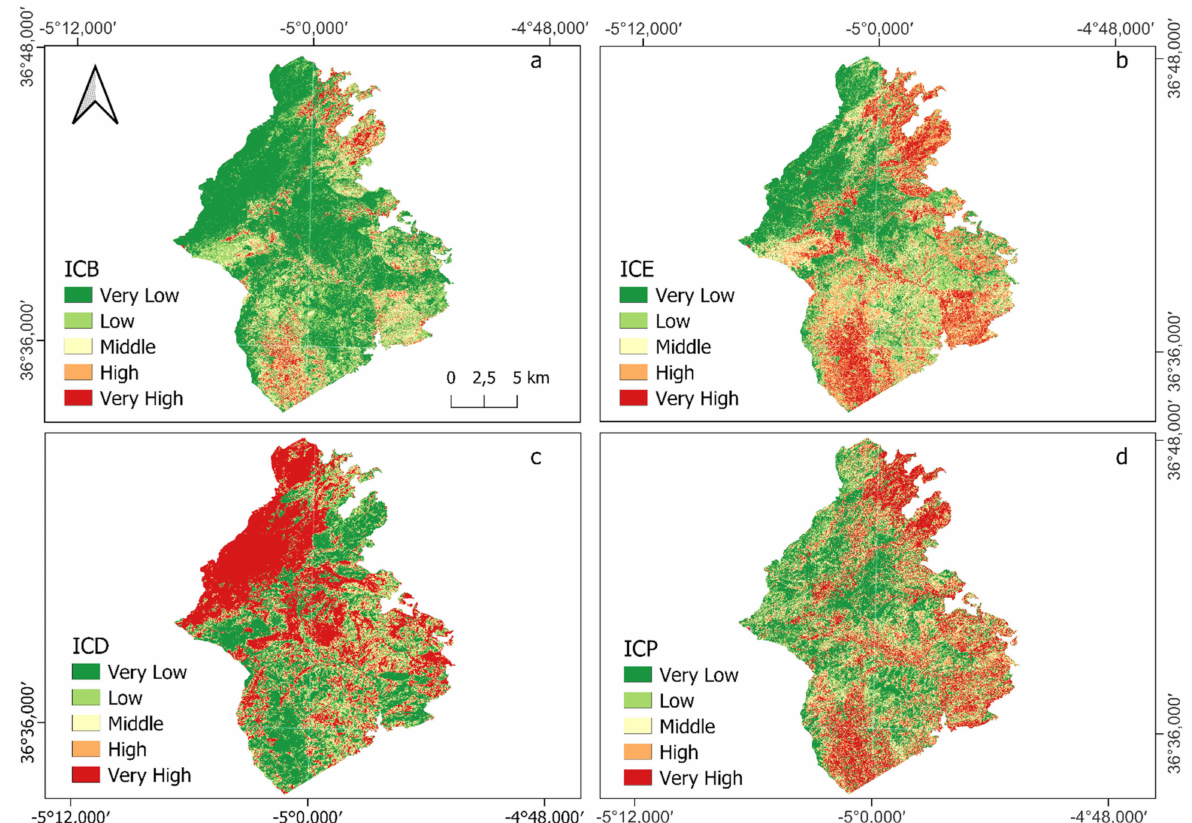
Figure 7. ( a ) Potential Behaviour Biomass Index (ICB), ( b ) Potential Behaviour Structural Complexity Index (ICE), ( c ) Potential Behaviour Fuel Desiccation Index (ICD), and ( d ) Potential Fire Behaviour Index (ICP) of forest types in Sierra de las Nieves National Park (M á laga, southern